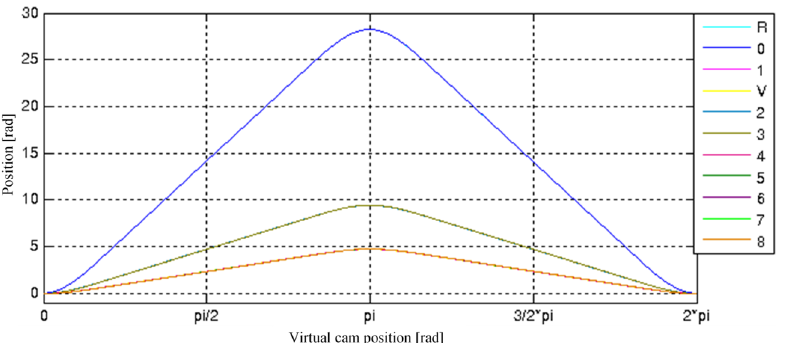
Figure 6. Courses of positions of individual drive system elements.